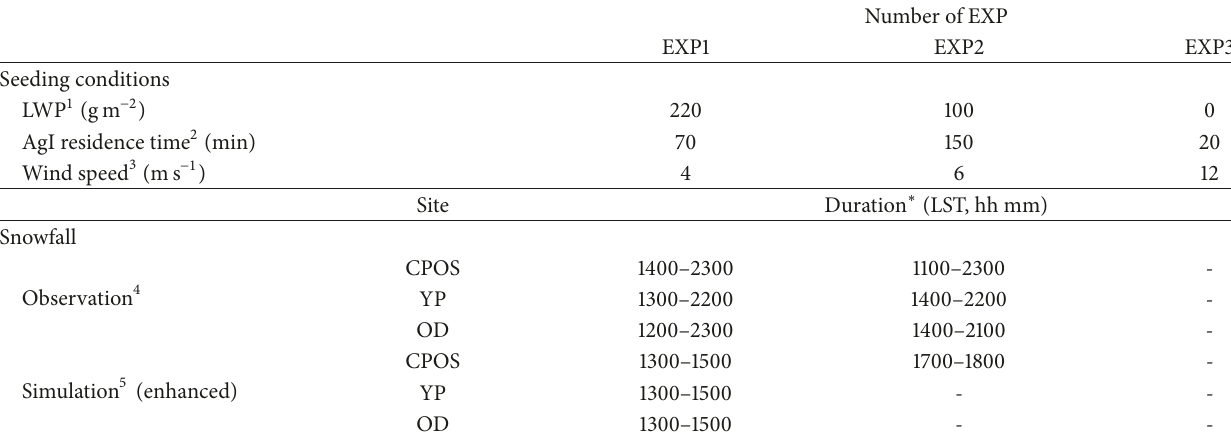
Table 2: Summary of the seeding experiments: seeding conditions and duration of the observed and simulated enhanced snowfall,